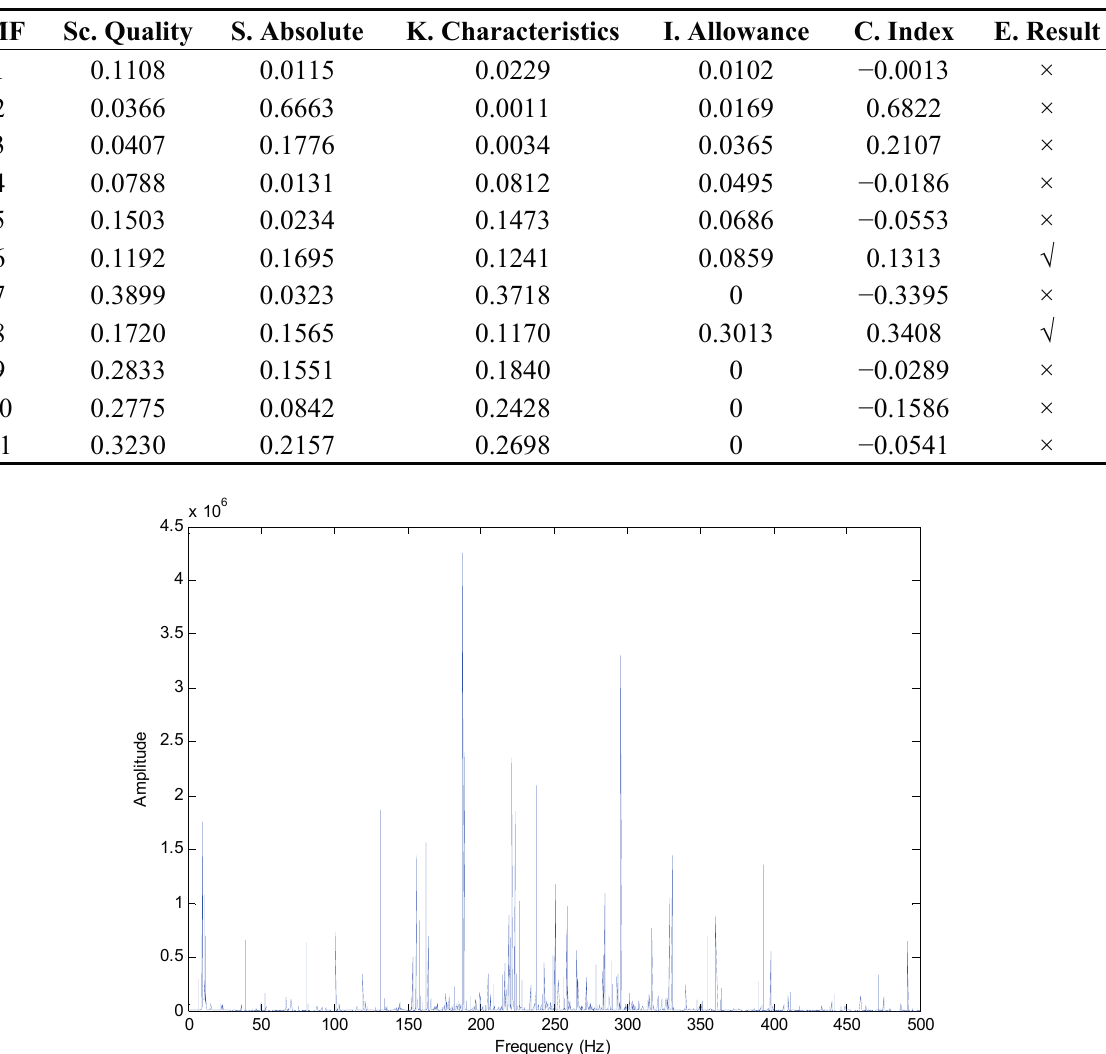
Table 5. IMFs’ confidence index calculation for the axle bearing vibration with pin roller fault.